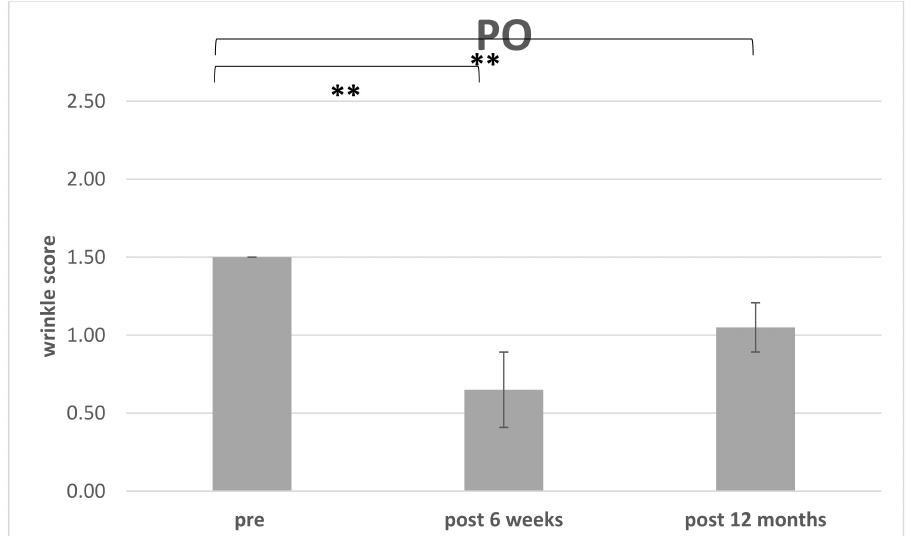
Figure 9. Improvement of the wrinkle severity scale related to the periorbital fold (PO): Comparison of WSS preoperative to 6 weeks and 12 months postoperative (** p < 0.01). The preoperative WSS for NLF was 1.81 ± 0.24 ( n = 14; range: 1.5–2) and after 6 weeks